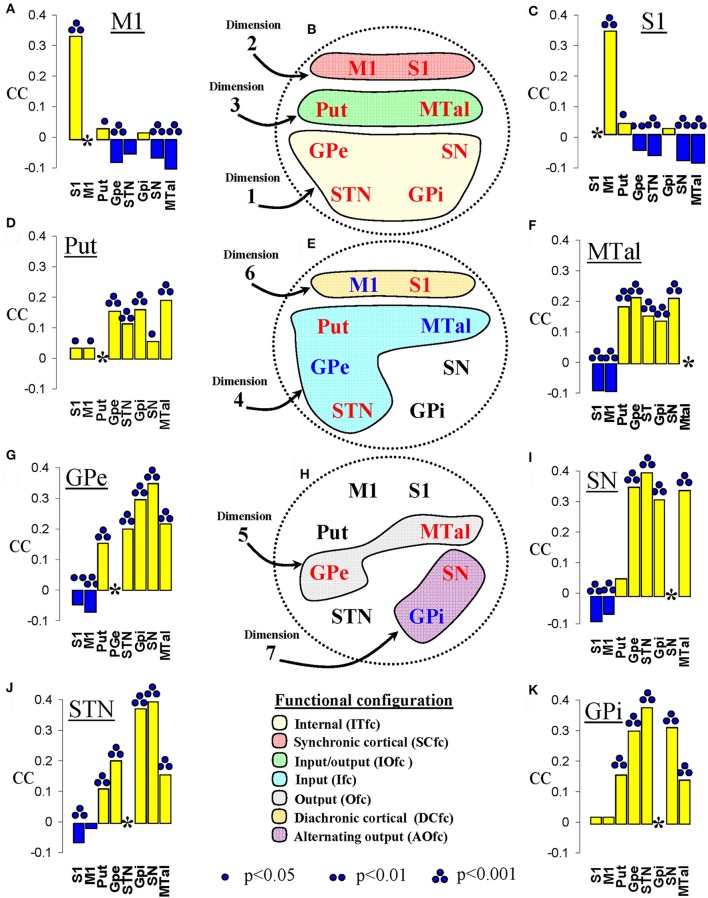
Correspondence coefficient (CC) and functional configurations identified by the multiple correspondence analysis. (A,C,D,F,G,I–K) show the CC between a center (underlined at the top of each figure) and all the other centers (indicated at the bottom of each figure). (B,E,H) Show the functional configurations identified by the MCA, each with the color indicated at the bottom of the figure and containing the name of the centers involved (in red color for centers found in positive coordinates and in blue color for centers found in negative coordinates). M1, primary motor cortex; S1, somatosensory cortex; Put, putamen; GPe, external globus pallidumN; STN, subthalamic nucleus; GPi, internal globus pallidum; SN, substantia nigral; MTal, motor thalamus; MTal.